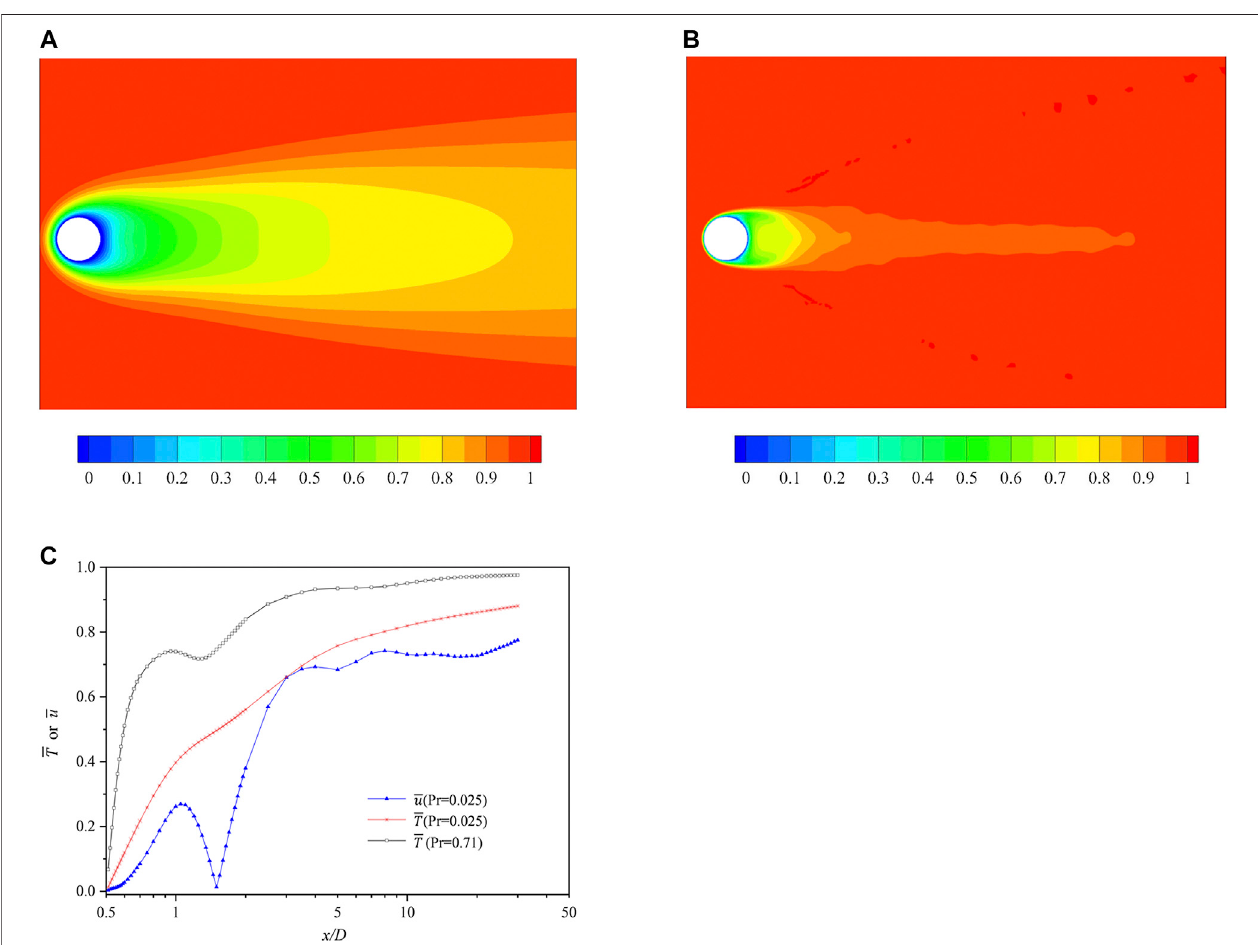
FIGURE 6 | Distributions of time-averaged temperature fi elds. (A) (cid:1) T around cylinder at z = 0 plane (LBE, Pr = 0.025); (B) (cid:1) T around cylinder at z = 0 plane (air, Pr = 0.71); (C) variation of (cid:1) T and (cid:1) u along the wake axis at z = 0 plane.